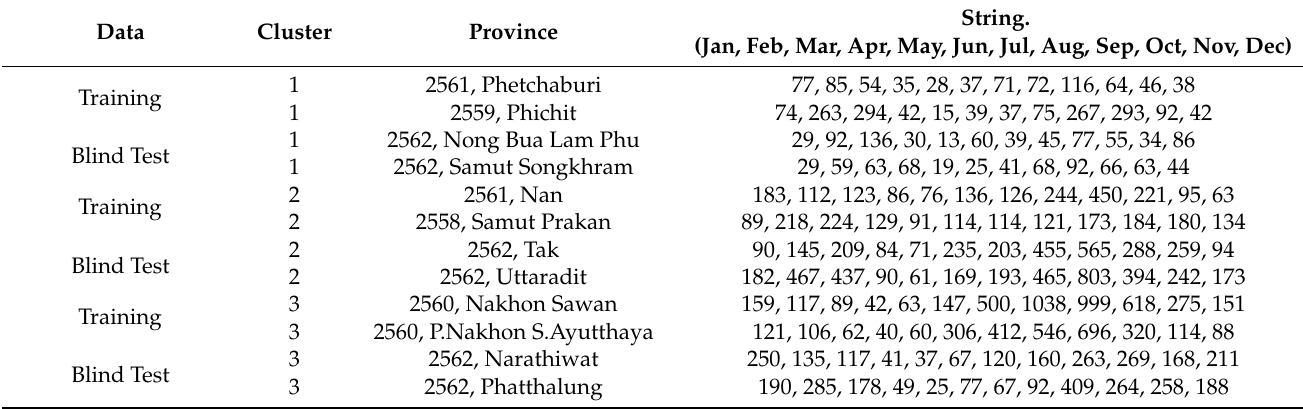
Table 14. The example of clustering results from the selected models for the influenza dataset for the month category.